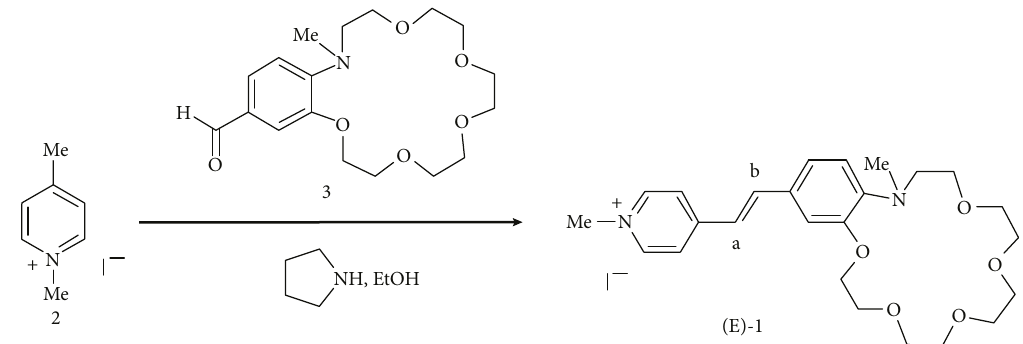
Scheme 1: Synthesis route of the dye OMS: iodide 1-methyl-4 - [(E) -2- (16-methyl-2,3,5,6,8,9,11,12,15,16-decahydro-14H-1,4,7,10,13,16- benzopentaoxaazazocycloooctadecine-19-yl) -vinyl] pyridinium (compound 1) using 1,4-dimethylpyridinium iodide (compound 2),